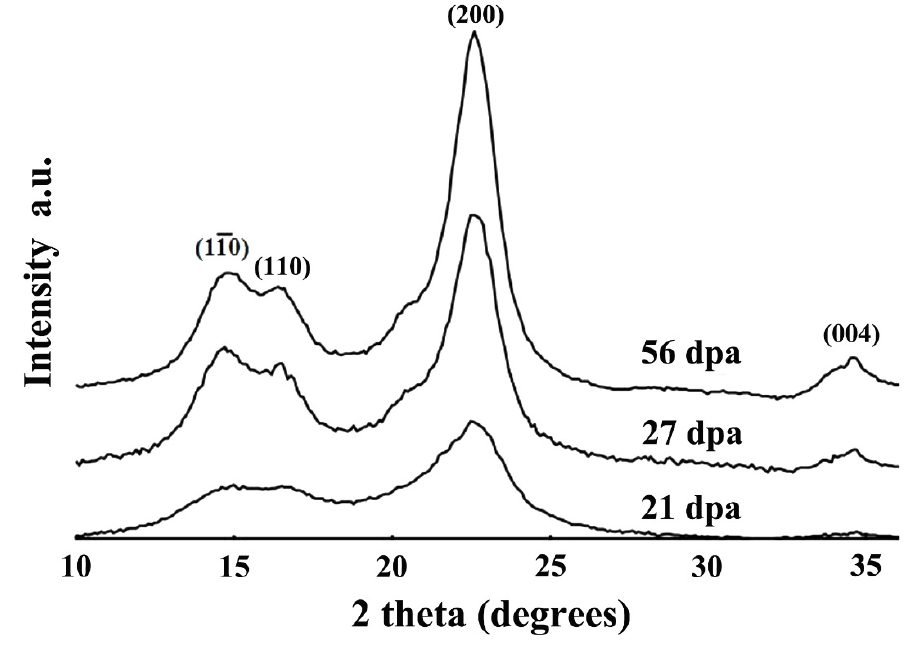
Figure 4. X-ray diffraction pattern of cotton fibers at different developmental stages: 21 dpa, 27 dpa and 56 dpa. The patterns are shifted vertically for